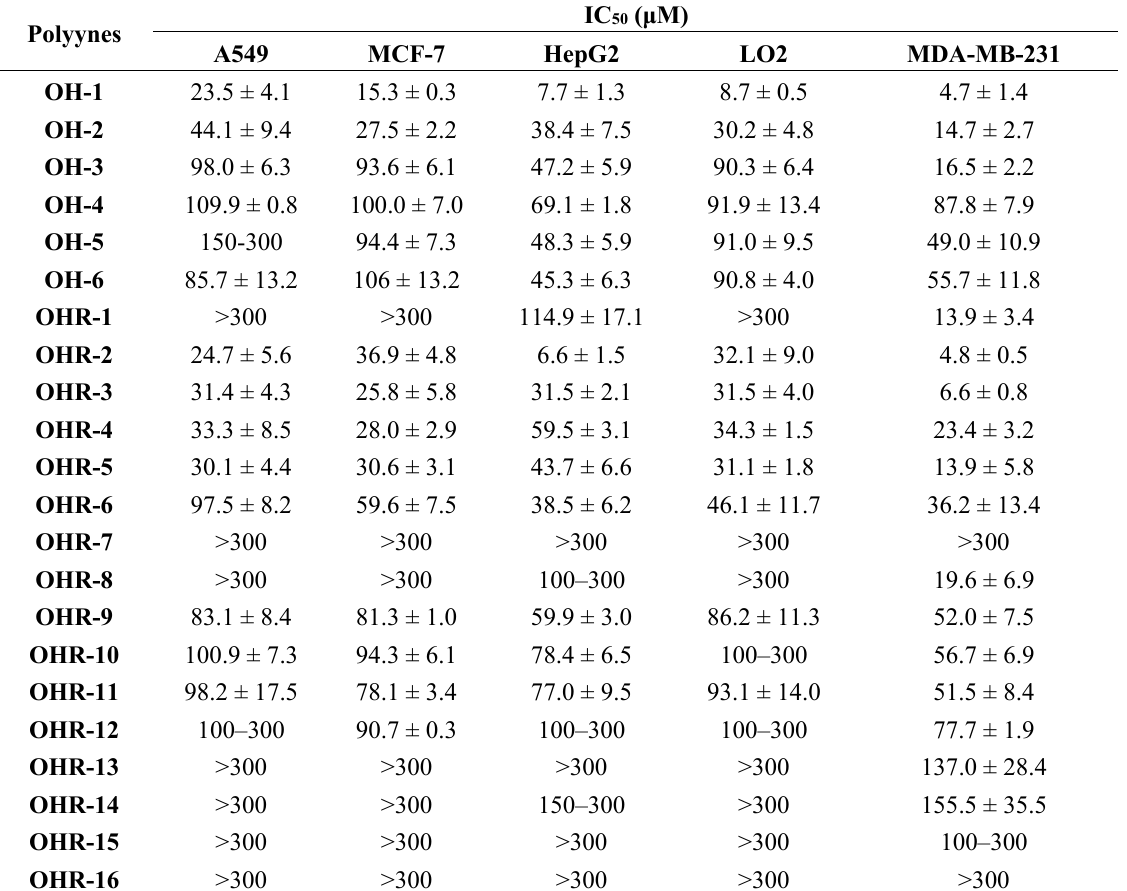
Table 1. Anticancer activities of polyynes from O. horridus and their acetylated